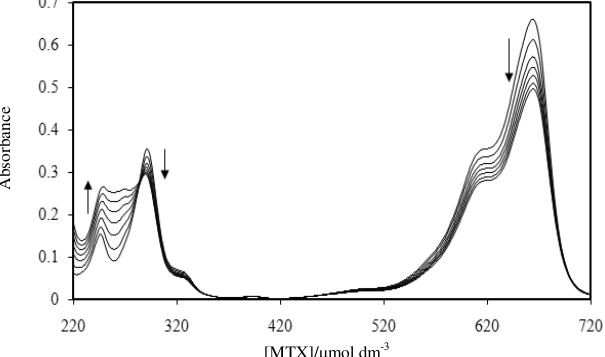
Figure 6. Absorption spectra of MB in the presence of DNA at different concentrations. = 0.0, 5.3, 10.0, 14.8, 19.1, 23.0 and 26.7 µ mol L -1 for curves 1-7 and C c DNA in phosphate buffer (0.1 mol L -1 , pH 7.4) plus NaCl (0.1 mol• L -1